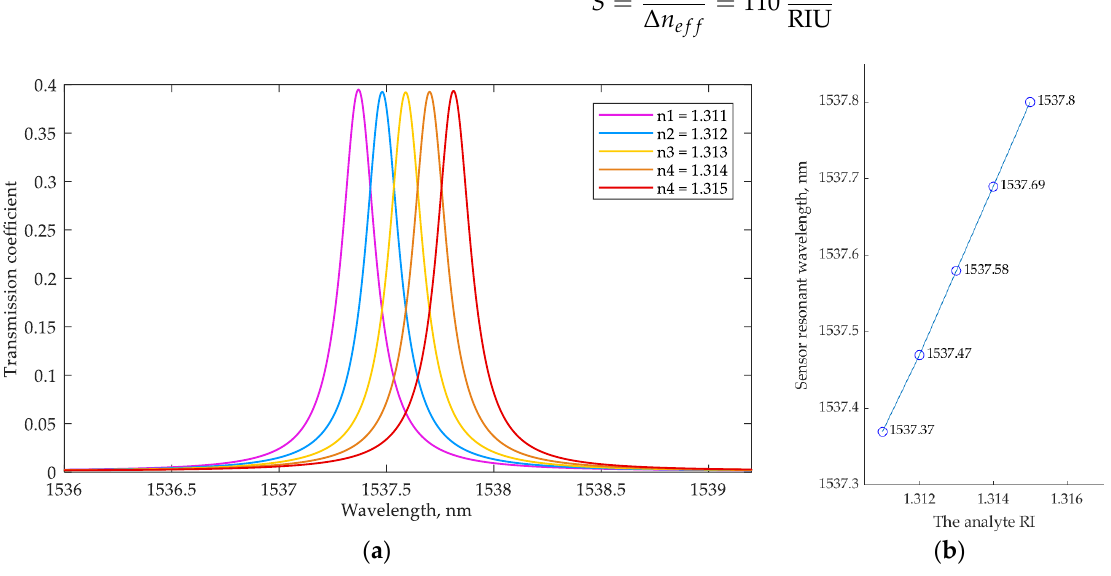
Figure 6. ( a ) The dependence of the sensor MRR transmission spectrum at the drop port on the analyte RI; ( b ) the dependence of the analyzed resonant wavelength of the sensor on the analyte